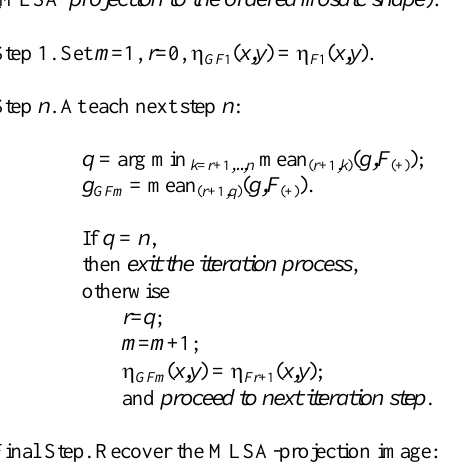
The Algorithm 1 iteratively forms the level representation